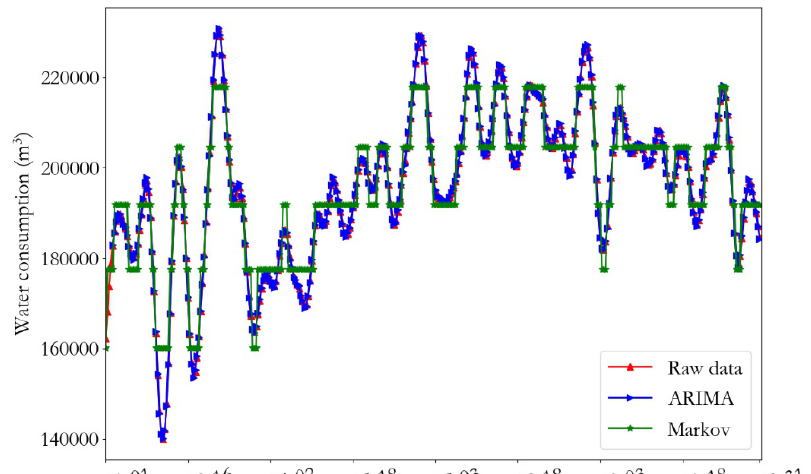
Figure 13. The relative error of the training data at monitoring point 1.